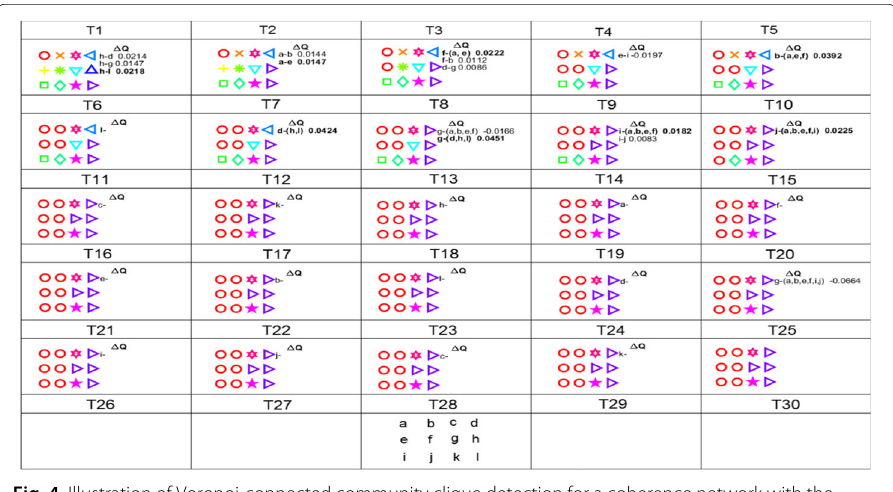
Fig. 4 Illustration of Voronoi-connected community clique detection for a coherence network with the coherence matrix shown in Table 1. Each colored symbol represents a community at T1 . For each step Ti , the gain (cid:5) Q is shown on the right. Before the dash: the node to be removed; after the dash: the node or nodes constituting a community. T28 shows the vertex positions in 2D